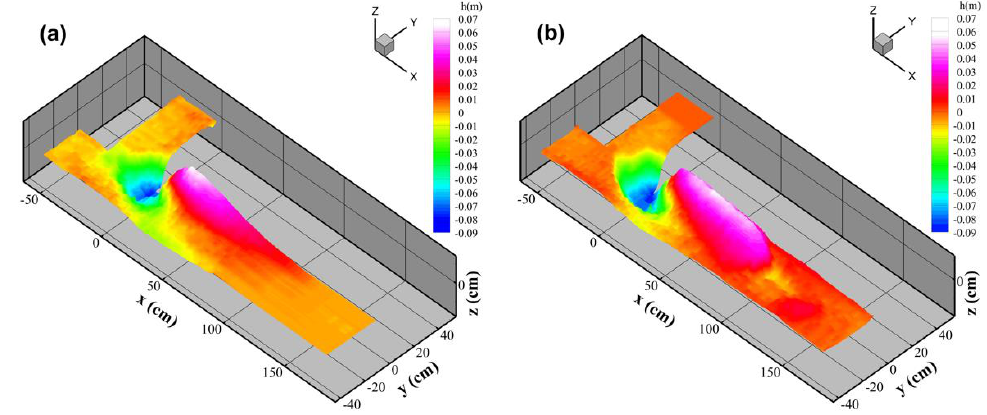
Figure 3. Three-dimensional bed topography of three cases. ( a ): case 1 and 3; ( b ): case 2.